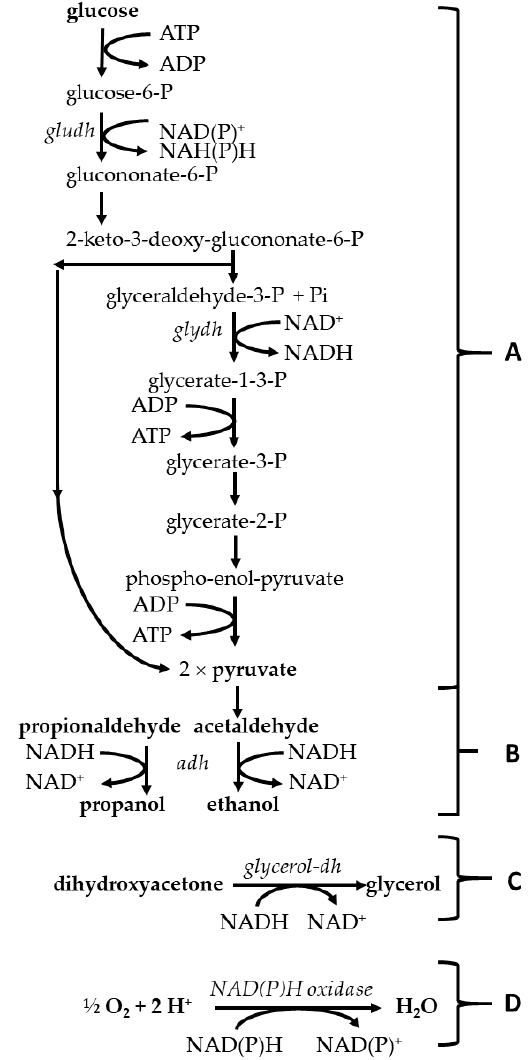
Figure 6. Metabolic pathways and enzymatic steps involving redox reactions. ( A ) Entner–Doudoroff pathway; ( B ) alcoholic fermentation involving alcohol dehydrogenase ( adh ); ( C ) conversion of dihydroxyacetone to glycerol via glycerol dehydrogenase ( glycerol-dh ); ( D ) oxidation of NAD(P)H to NAD(P) + via NADH(P)H oxidase. ( glydh = glyceraldehyde dehydrogenase), ( gludh = glucose dehydrogenase).